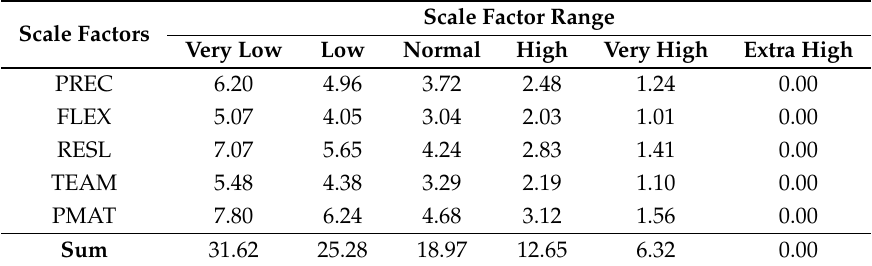
Table 4. COCOMO Scale Factors.